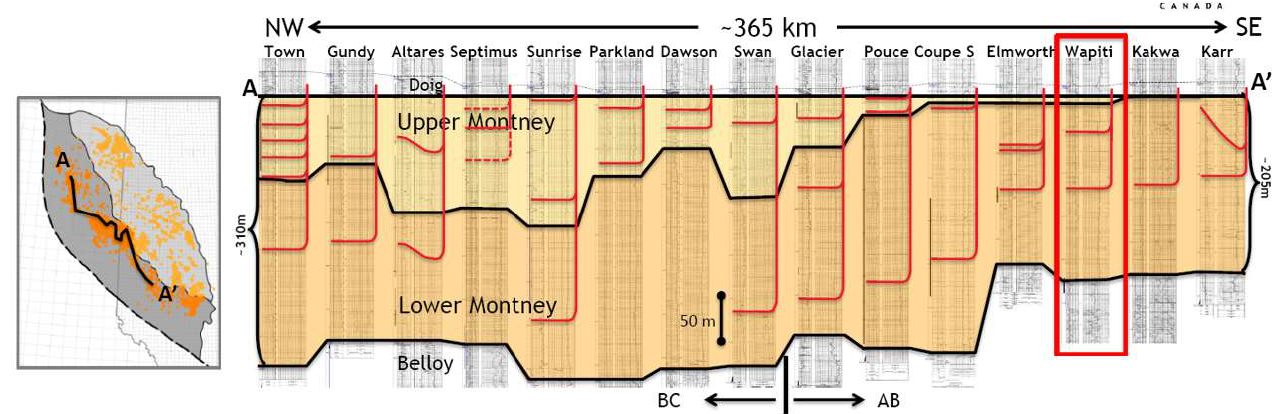
Figure 3. ( a ) Depositional environment of Montney Formation; ( b ) Montney conventional vs. unconventional plays.